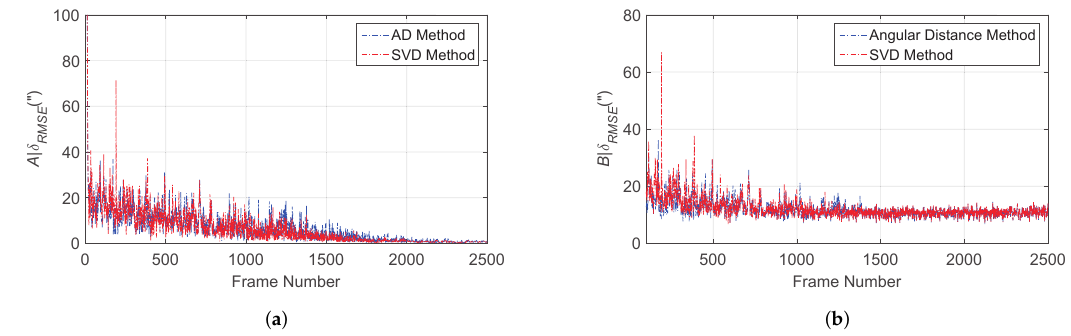
Figure 6. Residual errors of two calibration methods for Group 2. ( a ) Residual errors based on Criterion A and ( b ) residual errors based on Criterion B.